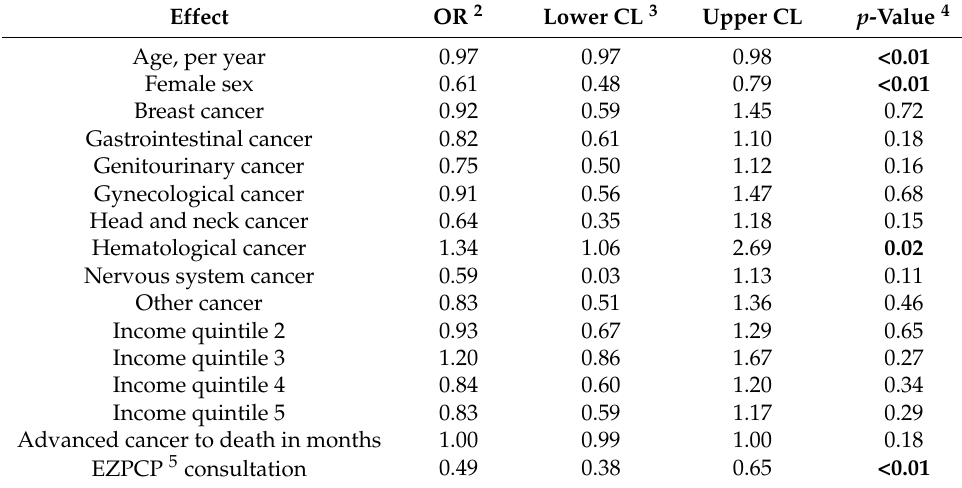
Table 2. Multivariable logistic regression analysis for presence of ≥ 1 indicator of aggressive care at the EOL 1. ( N =